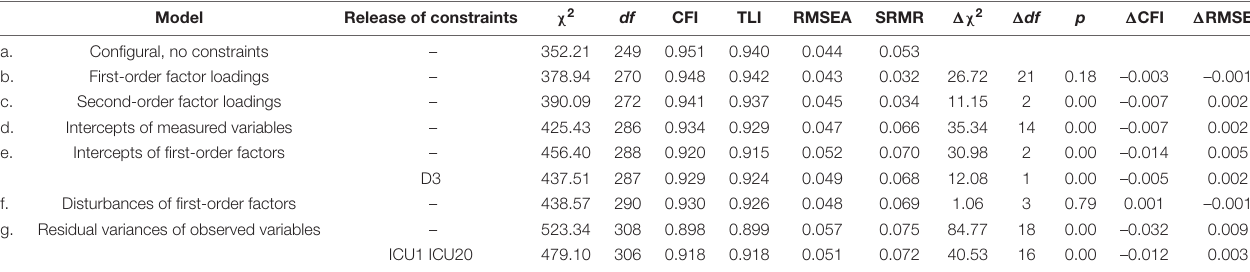
TABLE 3 | Multiple group measurement invariance analysis across the age period.